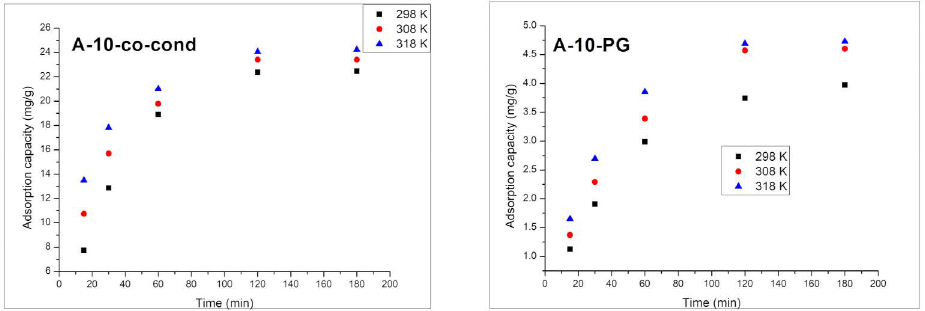
Figure 8. Adsorption capacity dependence on the contact time and temperature for the A-10-co-cond ( left ) and A-10-PG ( right )